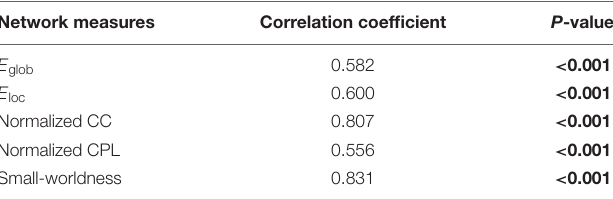
Network measures Correlation coefficient